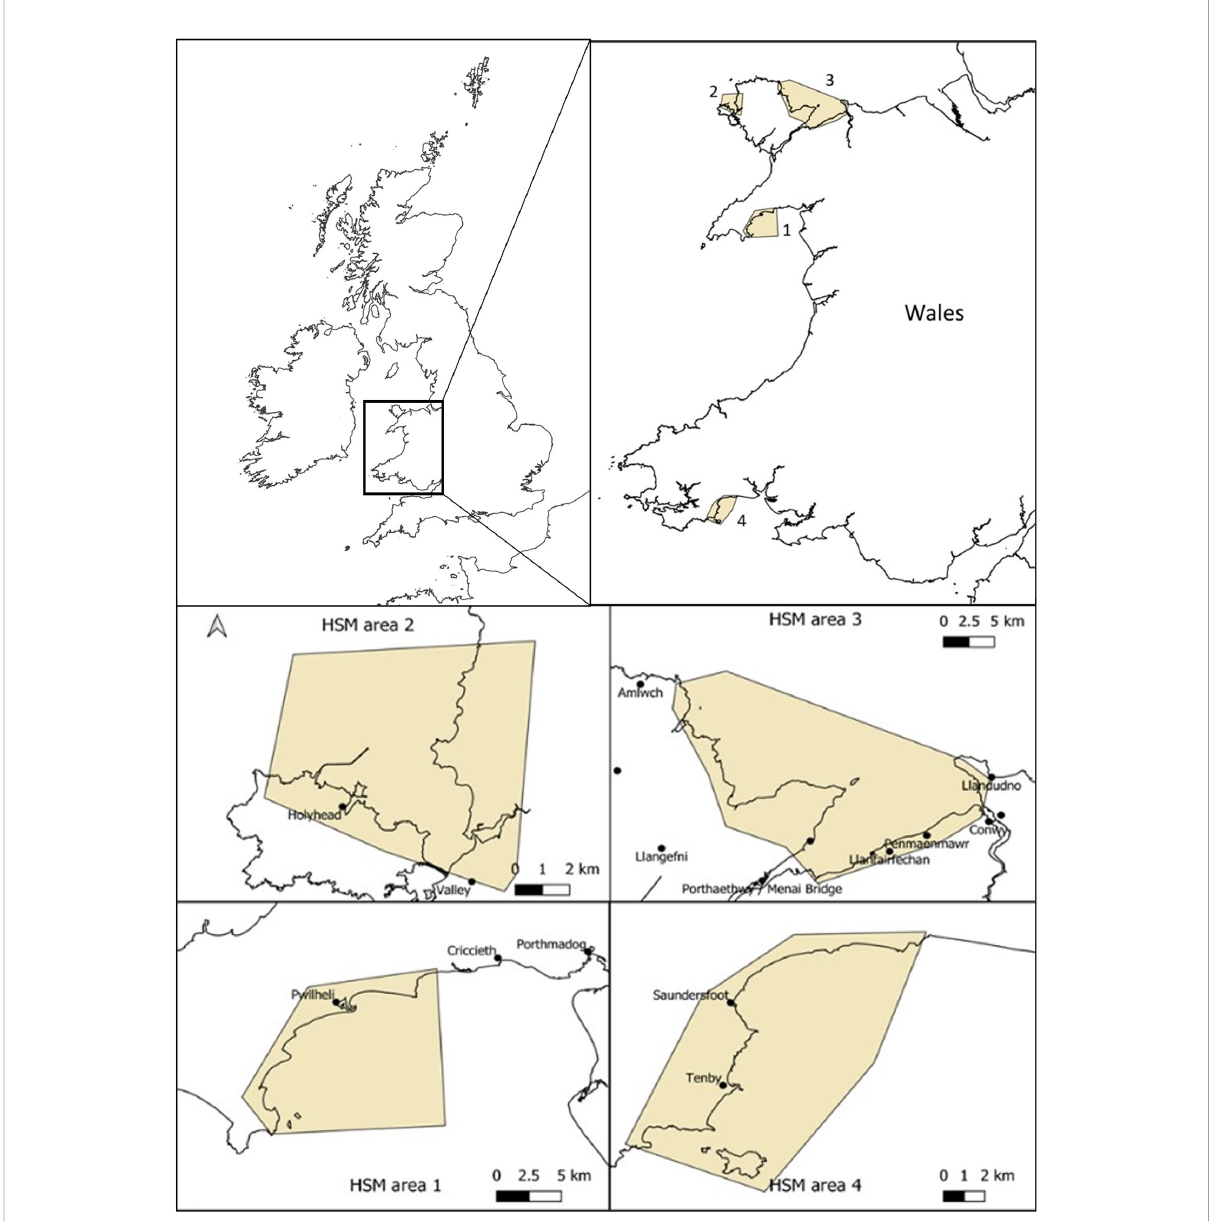
FIGURE 1 Sites for potential Zostera marina restoration around Wales (UK) used for high resolution habitat suitability modelling using high resolution wave model data. Areas start at Llyn Peninsula, north Wales (area 1), followed by west Anglesey coast (area 2), east Anglesey (area 3) and fi nally south Wales, Pembrokeshire (area